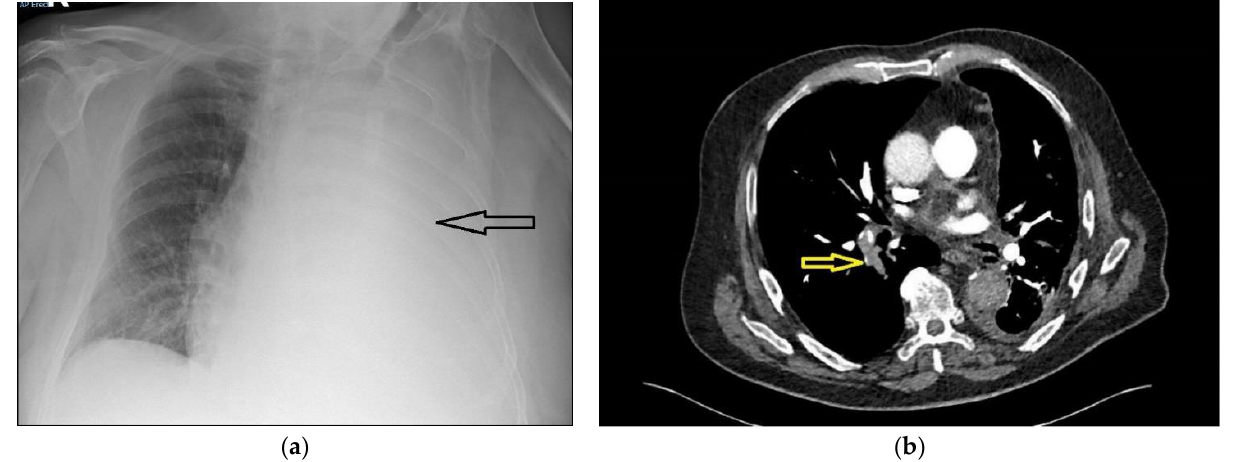
Figure 1. ( a ) Chest radiograph showing a large left-sided pleural effusion (marked with arrow); ( b ) slice of computed tomogram scan showing a right-sided pulmonary embolism (marked with arrow), small left-sided pleural effusion and pleural thickening consistent with a pleural malignancy.